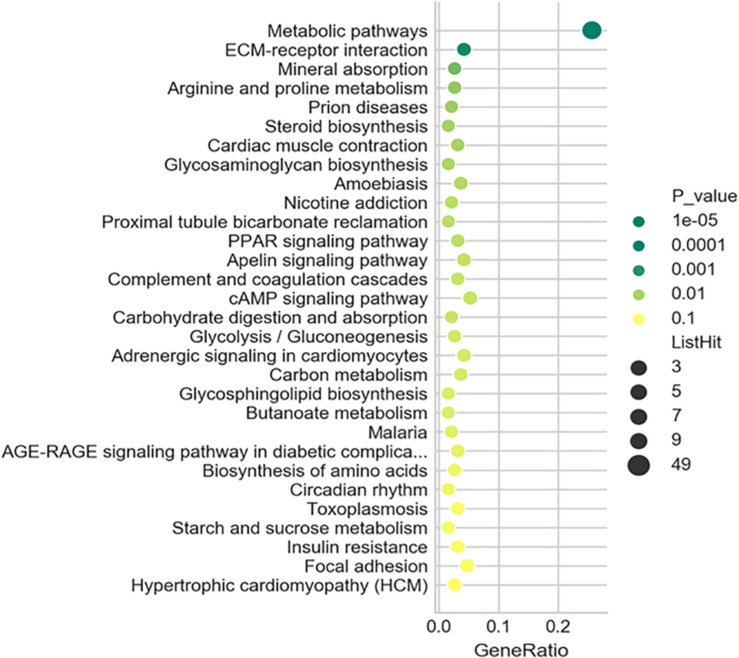
Kyoto Encyclopedia of Genes and Genomes (KEGG) analysis of the differentially expressed mRNAs. Top 30 terms in the pathway analysis of differentially expressed mRNAs after EgPSC infection. The larger the point, the more genes fall into this pathway and the greener point means higher significance of enrichment.